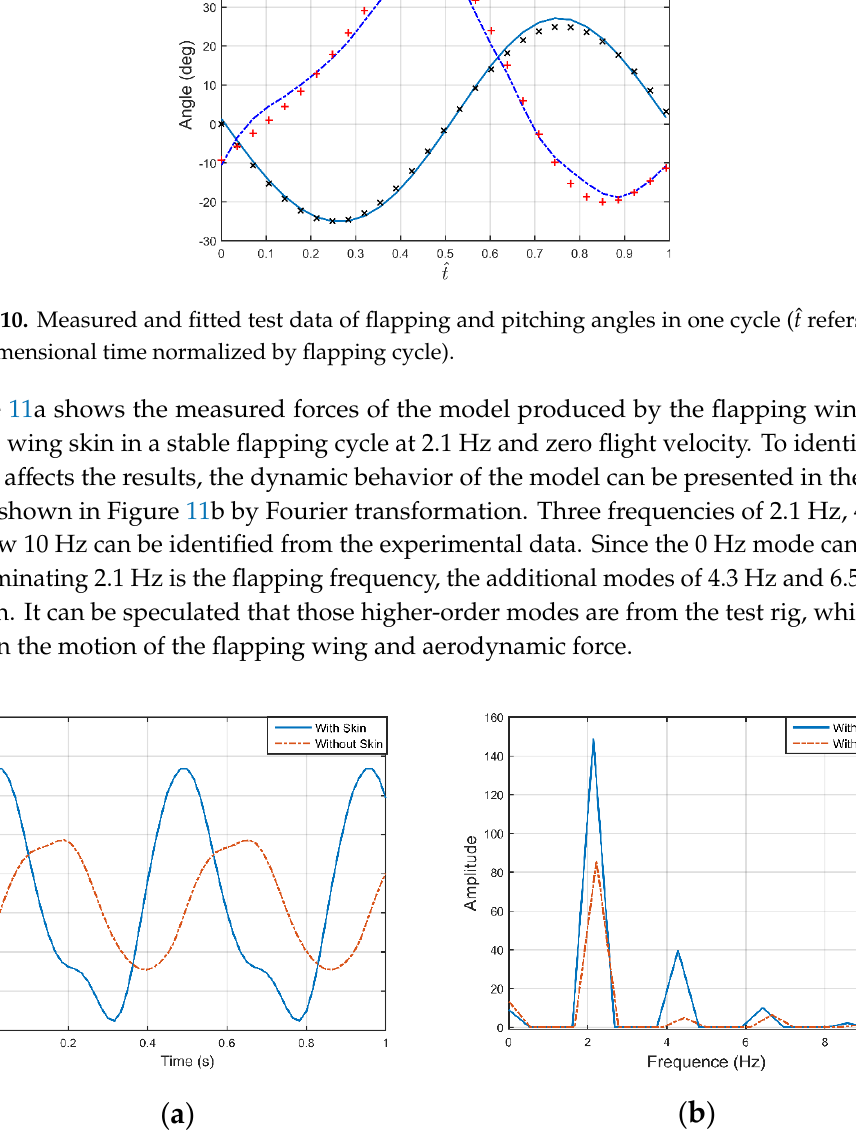
( b ) Figure 12. The aerodynamic lift ( a ) and drag (or thrust), ( b ) extracted from the experimental data.